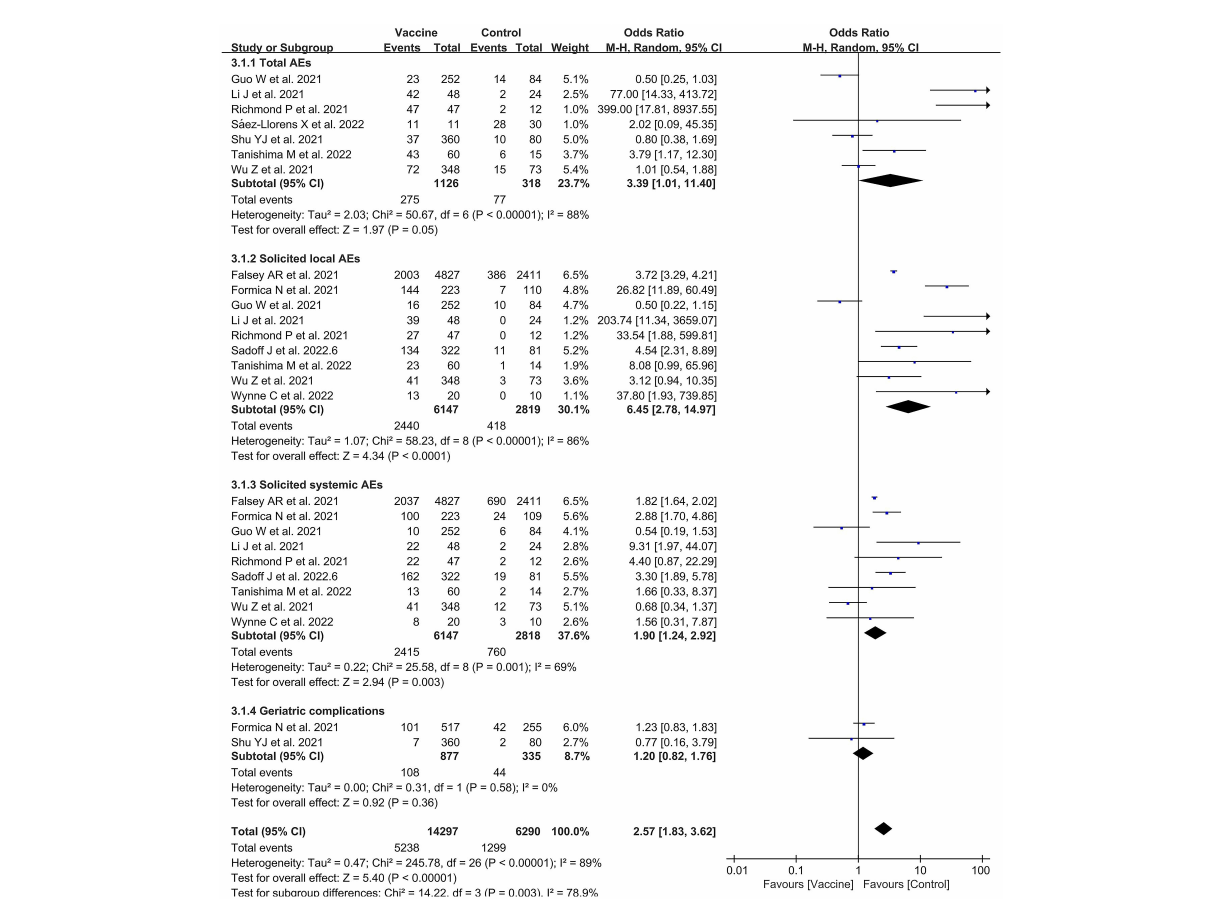
FIGURE 7 Forest plots of vaccine safety for the coronavirus disease 2019 (COVID-19) vaccine group compared with the control